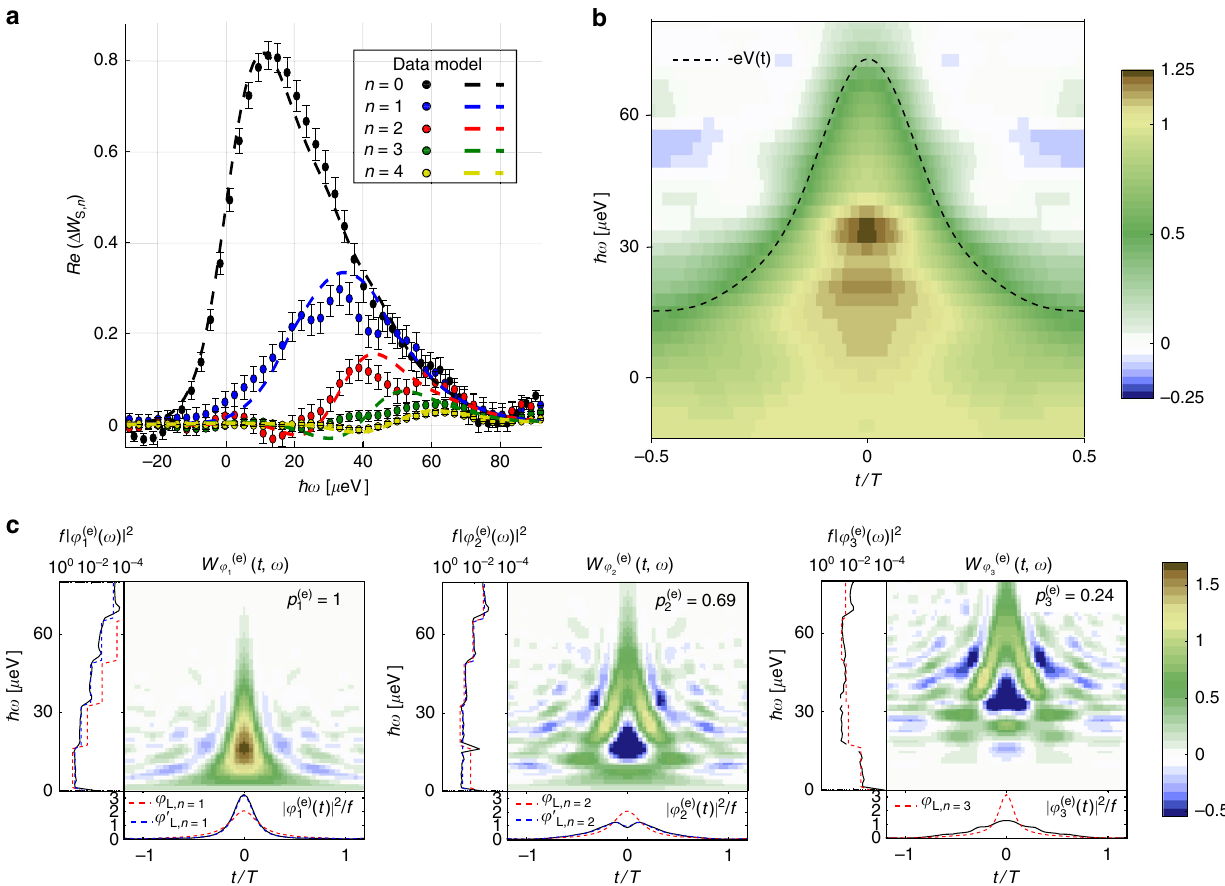
Fig. 6 Electron wavefunction generated by a Lorentzian pulse, q = − 2e. a Measured Δ W S, n ( ω ) ( n = 0 to n = 4) for the two-electron Lorentzian pulse at f = 4 GHz, τ = 42 ps, and T el = 50 mK. Error bars are de fi ned as standard error of the mean. b W S ( t , ω ), the dashed line represents the voltage pulse V ( t ) = h / e 2 I ( t ), where I ( t ) is obtained by integrating W S ( t , ω ) on energy ω . c Wigner representation of φ ð e Þ panels in the margins represent the time j φ ð e Þ represented in log scale. The red dashed line represent the theoretical predictions for the n = 1 to n = 3 wavefunctions of periodic trains of Lorentzian pulses φ L, n . The blue dashed lines represent the theoretical predictions for φ ′ L, n obtained from linear combinations of the φ L,